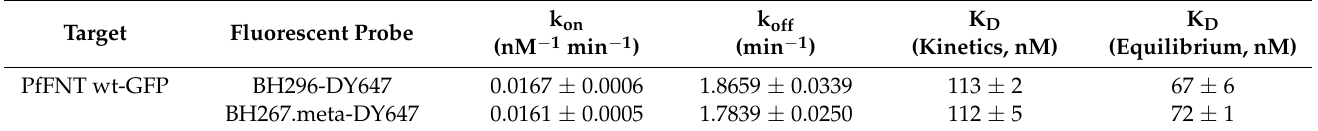
Figure 5. Kinetic studies of the fluorescent probes BH296-DY647 and BH267.meta-DY647 with PfFNT-GFP by FCCS. Time resolved measurements of the interactions were carried out to obtain k obs -values. The k obs -values were plotted versus concentrations of the fluorescent probe. The solid line represents the best linear regression, and k on and k off of both fluorescent probes were estimated from the slope and y-intercept, respectively. k on and k off values of BH296-DY647 and BH267.meta-DY647 are summarized in Table 3.